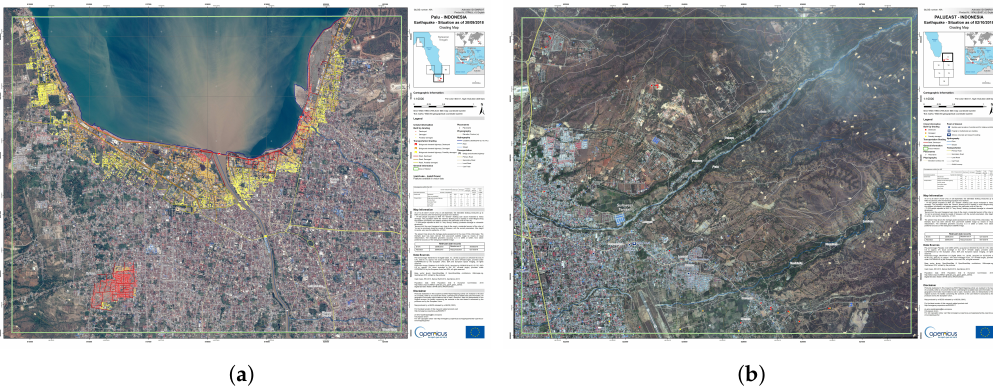
Figure 2. Considered areas (Source: [52]). ( a ) AoI 7, Palu and ( b ) AoI 11, East Palu.